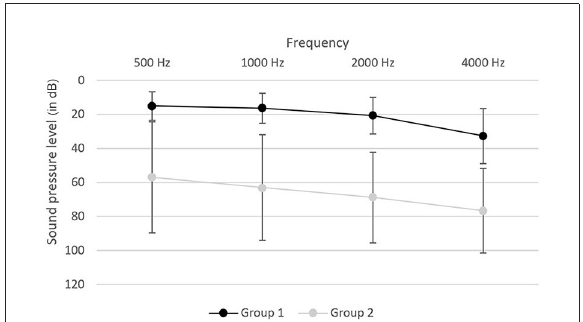
FIGURE1 Audiogram of group 1 and group 2. Testing was performed in the frequencies of 500, 1000, 2000 and 4000Hz and graphs are shown for the mean sound pressure level in dB with the standard deviation on the better hearing